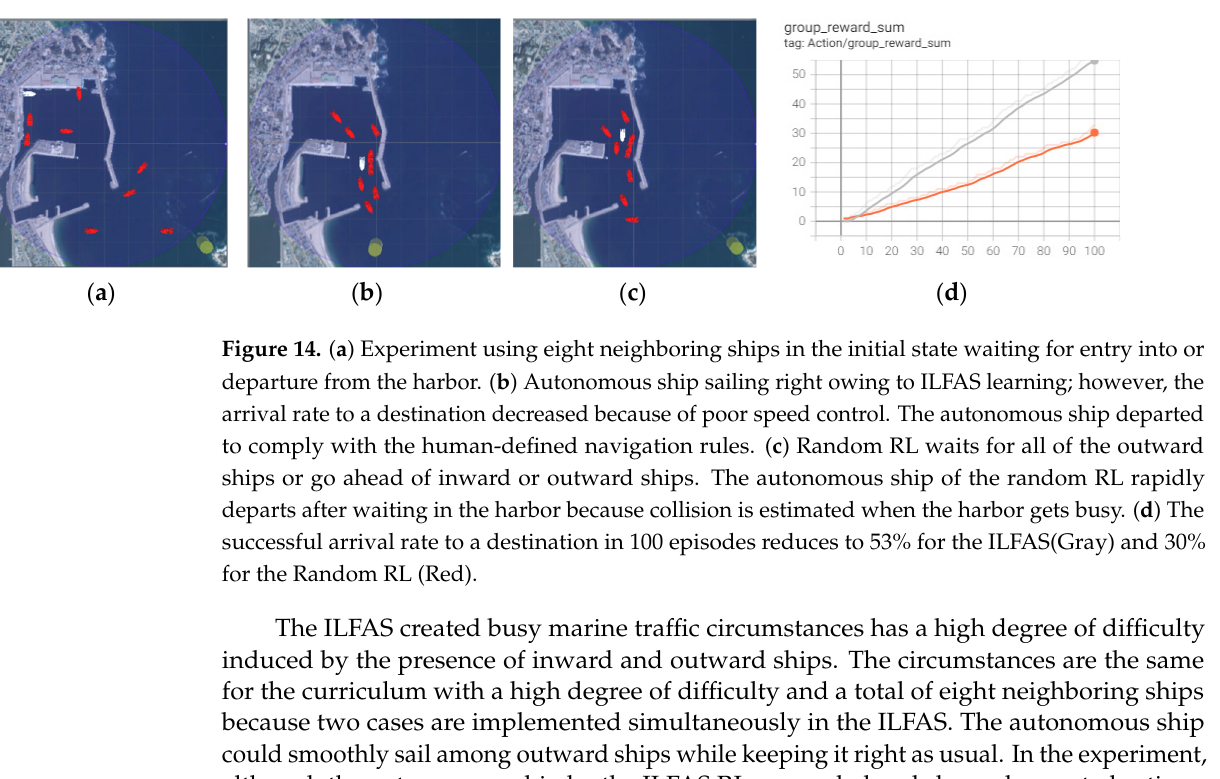
Figure 13. Actions of the autonomous ship. The autonomous ship is controlled by [acceleration/deceleration] and [steering]. The random and ILFAS RL are shown in red and green, respectively. The graph, keeping direction without controlling the speed, shows the stability of the autonomous ship. The graph for the ILFAS also shows the decrease in the stability of control in the environment that is not learned.